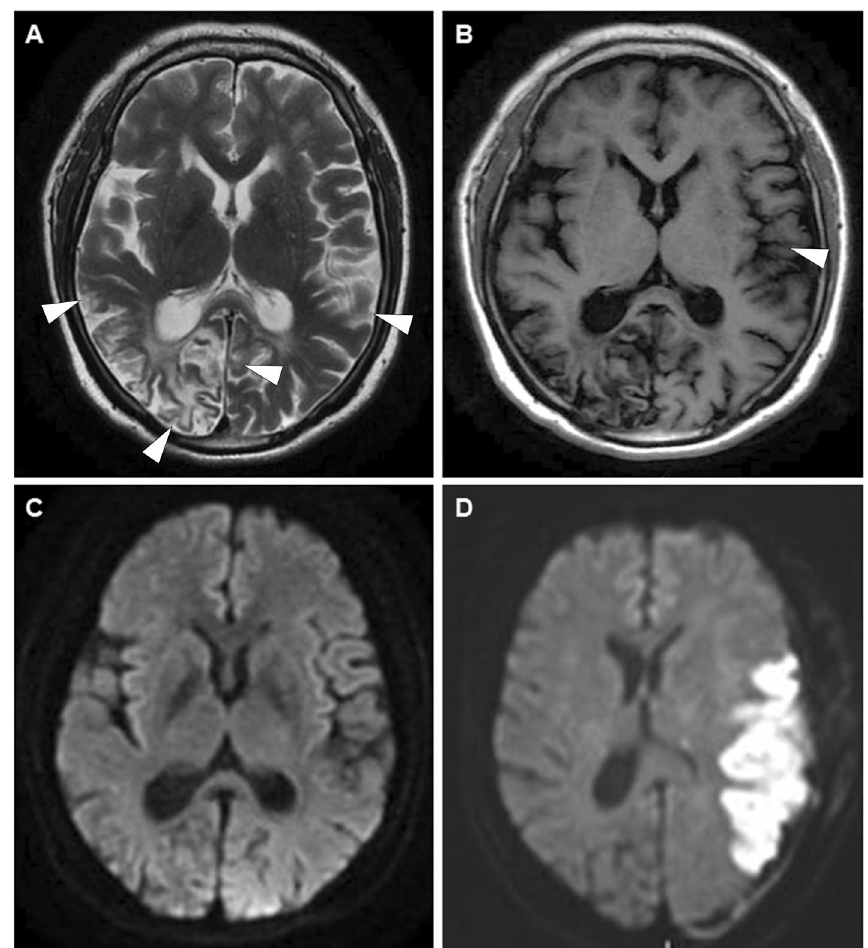
Figure 3. MR images obtained pre and postoperatively represent ischemic lesions. ( A – C ) T2-weighted, T1-weighted and diffused weighted MR images showed preoperative infarction in bilateral of temporal lobe and occipital lobe (white arrowheads). CIES = 7 point. ( D ) Diffused weighted MR images showed acute cerebral infarction in left temporal and occipital lobe